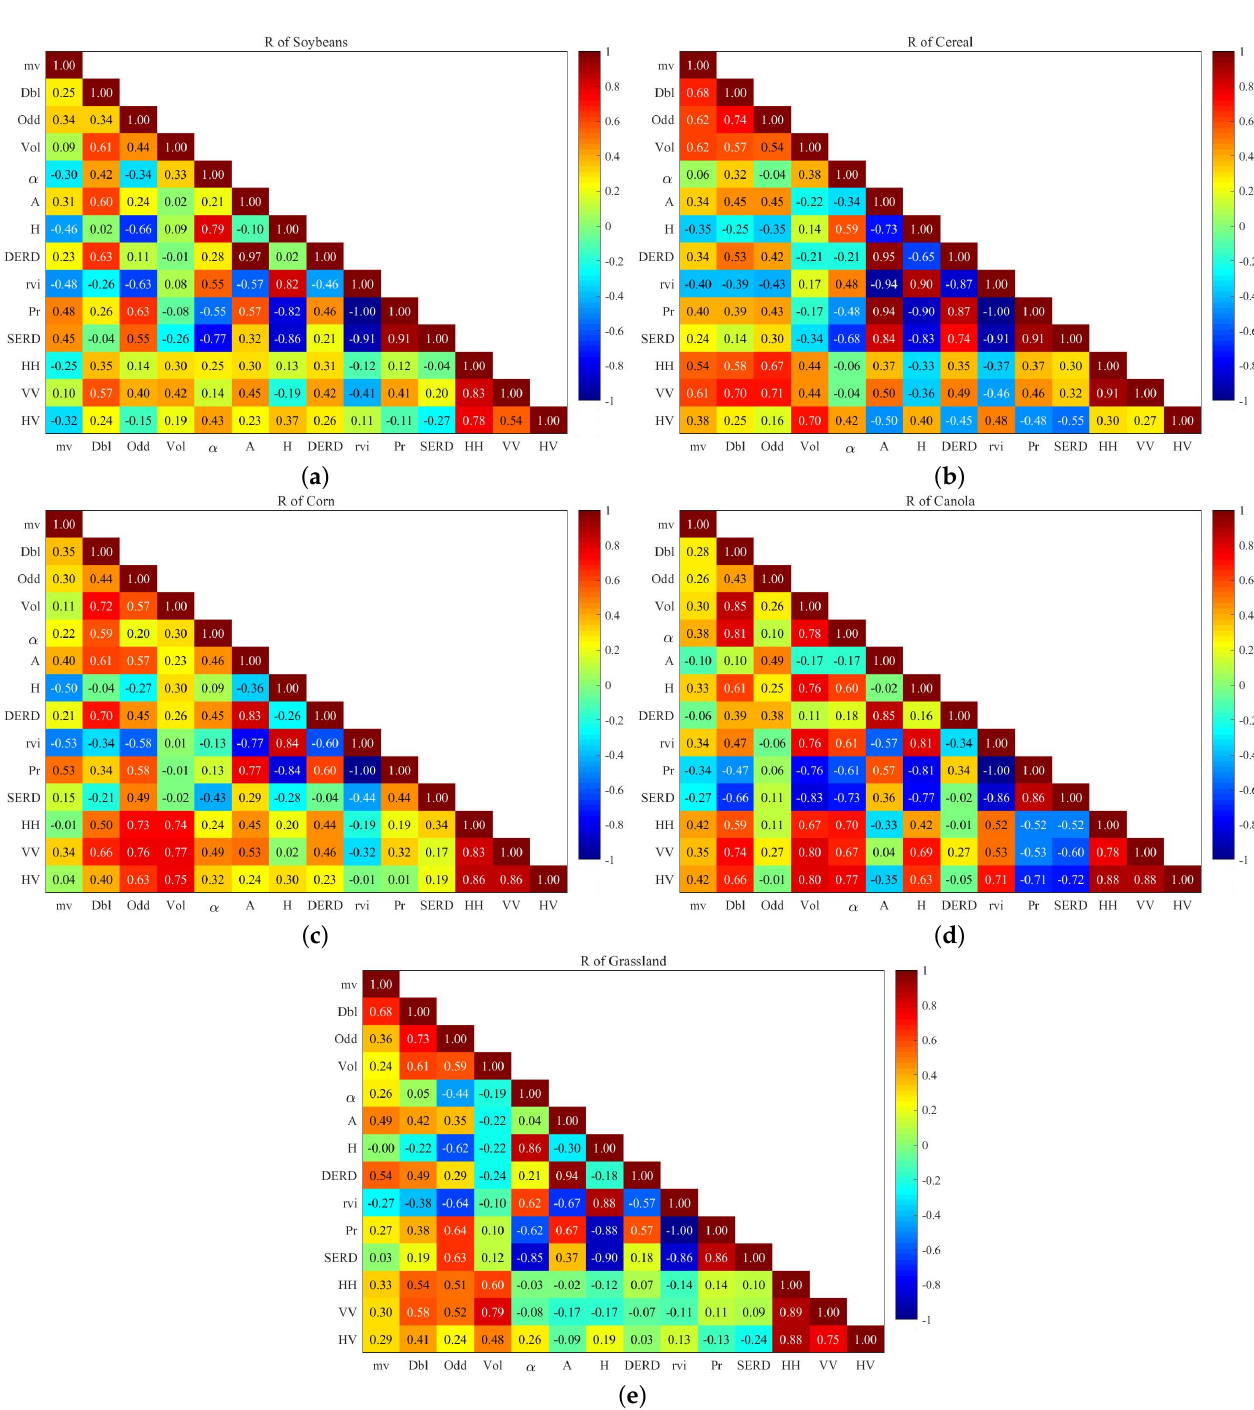
Figure 4. Correlation coefficient matrices of in situ SSM and some commonly used polarimetric de- composition parameters under different crop coverage. ( a ) correlation coefficient matrix of soybeans; ( b ) correlation coefficient matrix of cereal; ( c ) correlation coefficient matrix of corn; ( d ) correlation coefficient matrix of canola; ( e ) correlation coefficient matrix of